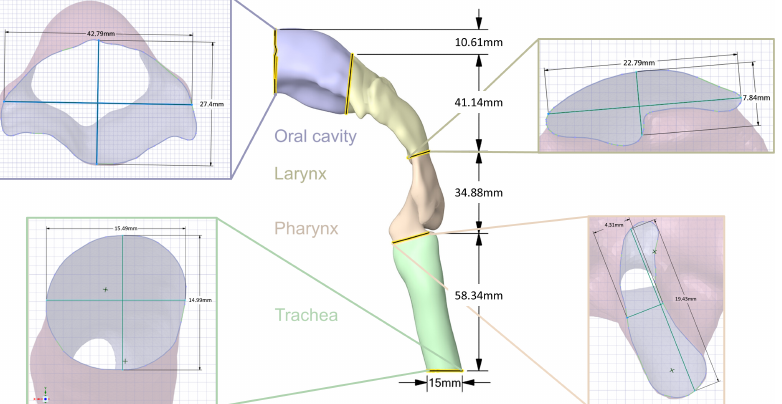
Figure 2. The manufactured 3D model of an upper respiratory tract of a 28-year-old, healthy, nonsmoking,